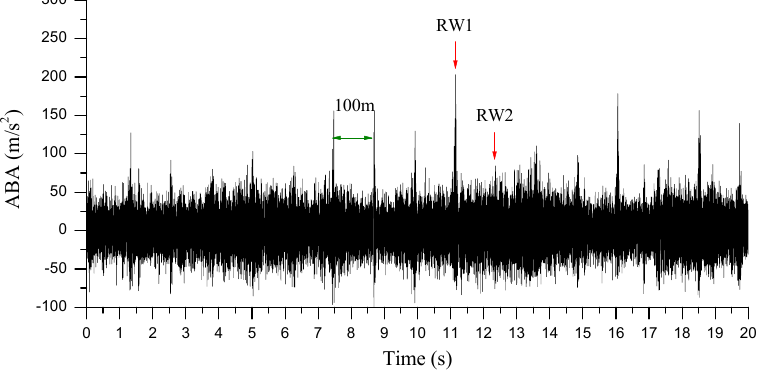
Figure 4. Time-course response of measured ABA under 300 km/h. RW1 and RW2 are two examples of rail welds.